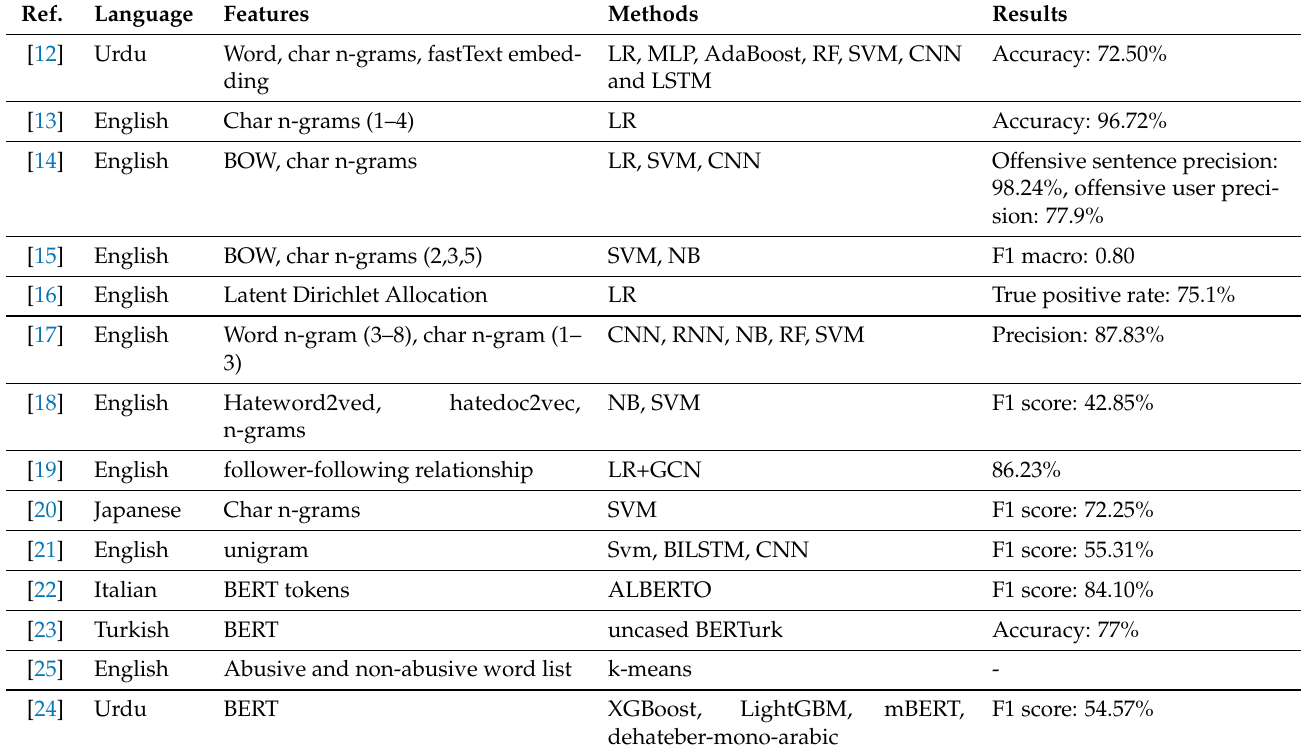
Table 1. Comparative overview of the discussed research